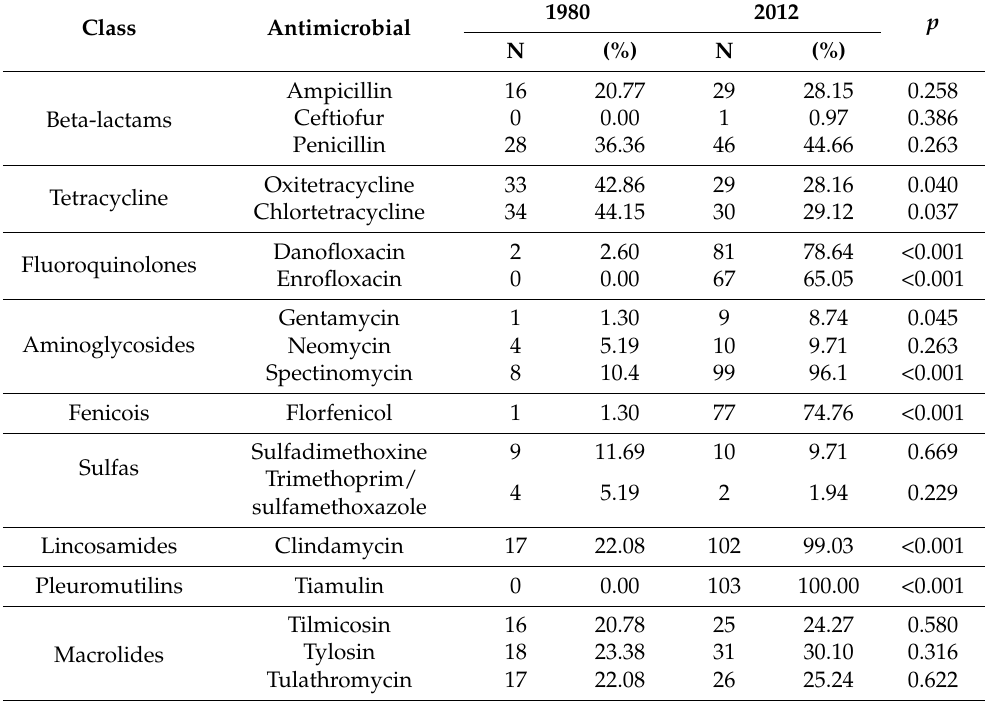
Table 3. Resistance rates of S. hyicus from the 1980s and 2012 against tested antimicrobials.